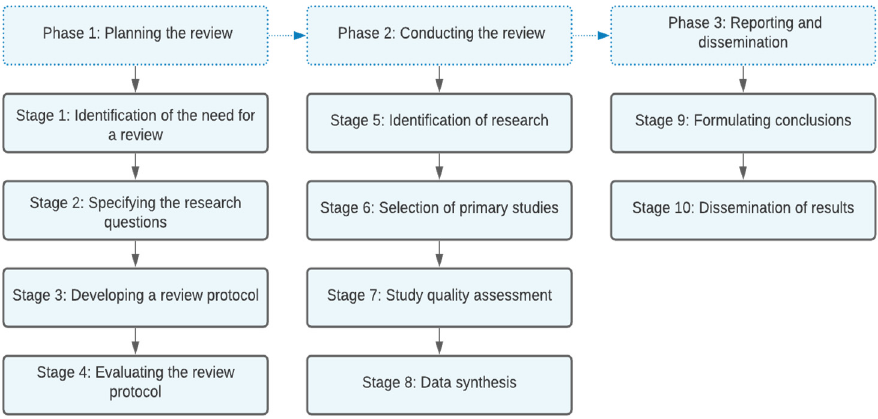
Figure 1. Systematic review steps adapted from Kitchenham